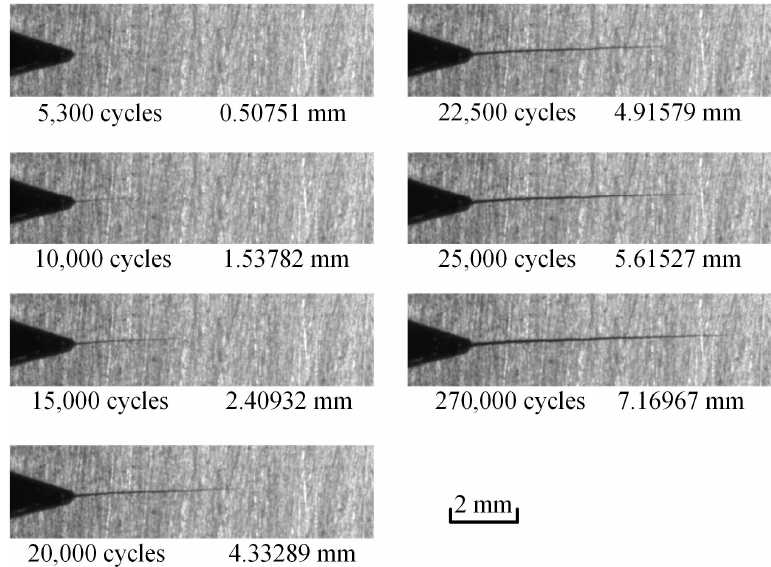
Figure 9. Global crack images corresponding to different cycle numbers.